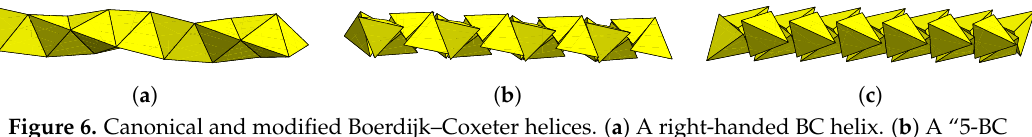
Figure 6. Canonical and modified Boerdijk–Coxeter helices. ( a ) A right-handed BC helix. ( b ) A “5-BC helix” may be obtained by appending and rotating tetrahedra by β using the same chirality of the underlying helix. ( c ) A “3-BC helix” may be obtained by appending and rotating tetrahedra by β using the opposite chirality of the underlying